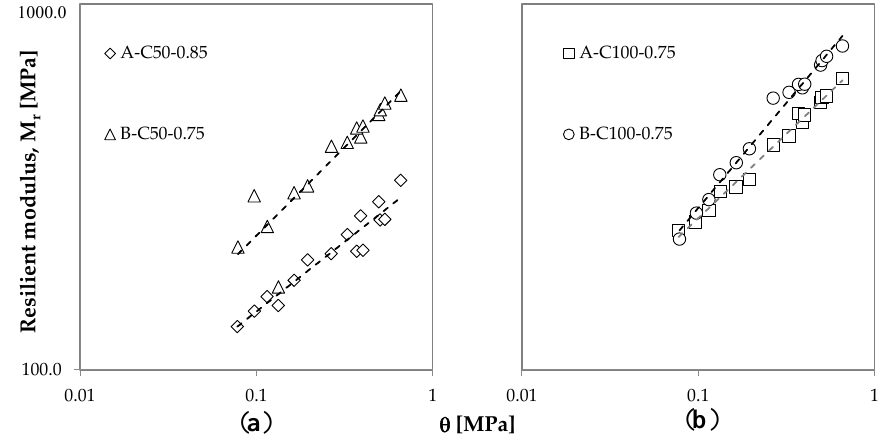
Figure 3. Results of M r tests performed after 7 days of curing: ( a ) FTB mixtures with cement content 50 kg/m 3 ; ( b ) FTB mixtures with cement content 100 kg/m 3 .